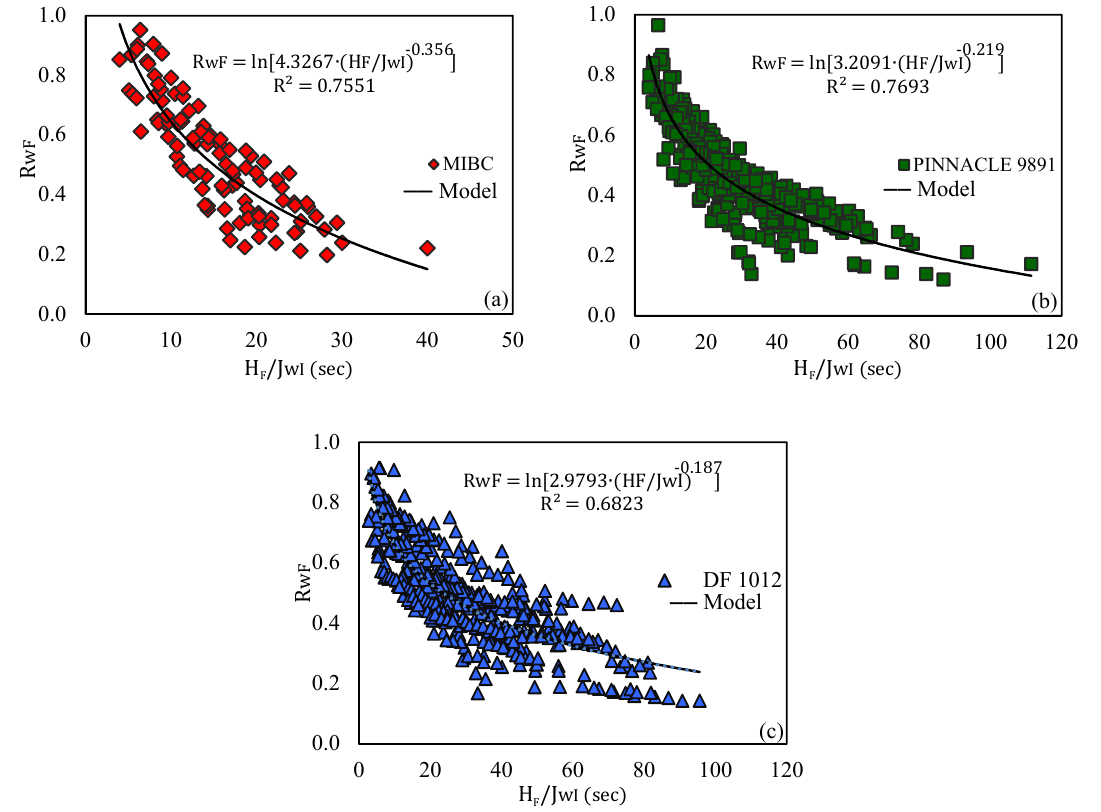
Figure 6. Froth water recovery as a function of the average liquid retention time in the froth (H F / J wI ) for ( a ) MIBC, ( b ) PINNACLE 9891, ( c ) DF 1012.